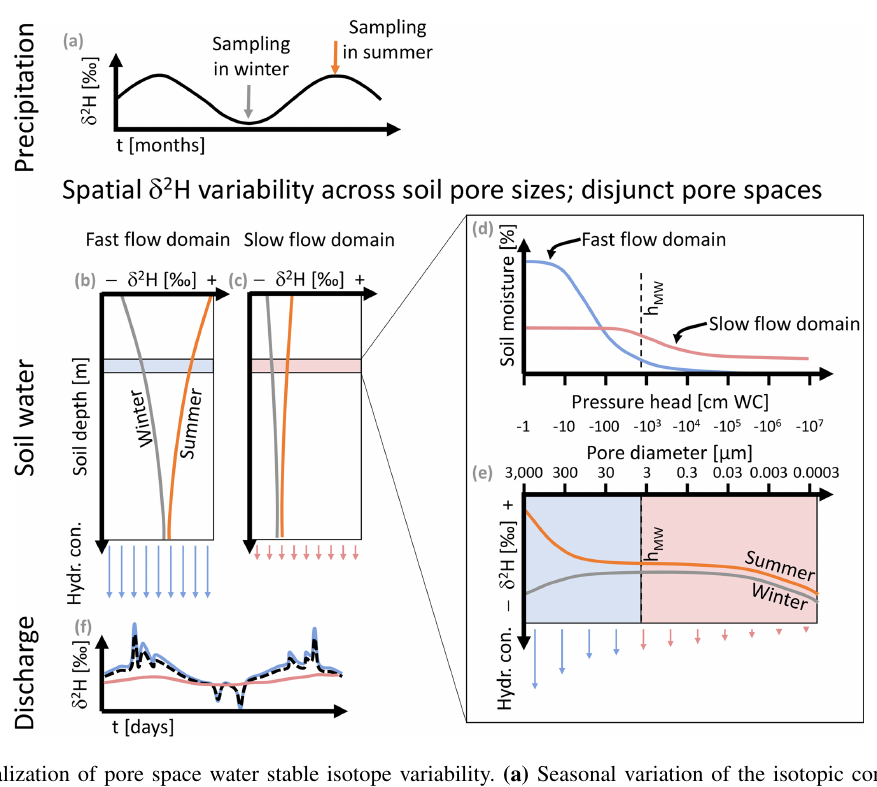
Figure 7. Conceptualization of pore space water stable isotope variability. (a) Seasonal variation of the isotopic composition in rainfall. Arrows indicate soil sampling days. (b) Isotope depth profile of the fast flow domain (mobile water) during winter (grey) and summer (orange). The arrows below the profile represent the hydraulic conductivity. (c) Same as (b) , but for the slow flow domain (tightly bound water). (d) Water retention curve based on the dual-porosity model as proposed by Gerke and van Genuchten (1993) for the fast (blue) and slow (red) flow domain with h MW indicating the threshold for suction of lysimeter sampling. (e) Isotopic compositions across the pore space at a specific depth as shown in (b) and (c) with blue and red shaded areas representing mobile and tightly bound water pore space, respectively. Note that (d) and (e) share the same x axis, representing the pressure head and pore diameter based on Schjonning (1992). Vertical arrows in (b) , (c) , and (e) represent hydraulic conductivity in the fast (blue) and slow (red) flow domain. (f) Isotopic composition of the discharge from the soil subdivided into fast (blue) and slow (red) flow contributions and the resulting total isotopic composition (black dashed